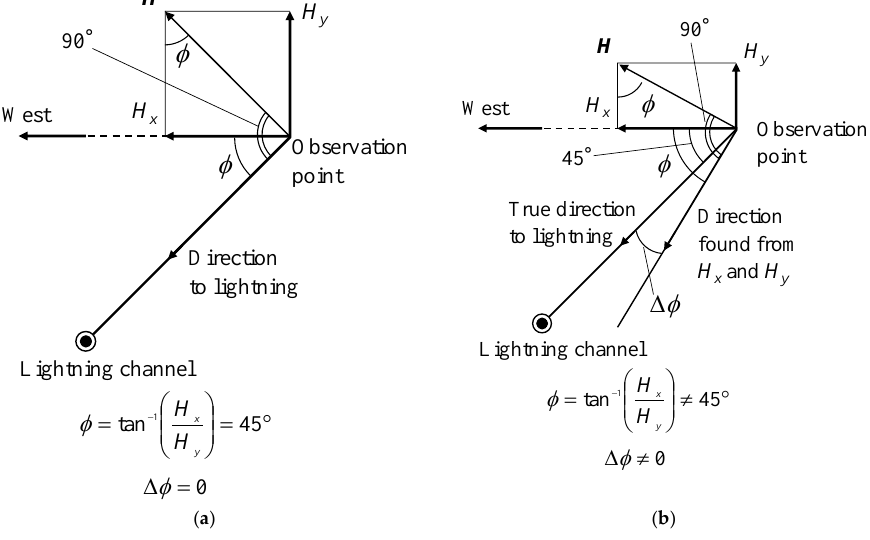
Figure 3. Illustration of lightning direction finding from H x and H y for the case of the true lightning azimuth φ = 45 0 : ( a ) Ideal case of no azimuth error (direction found from H x and H y is the same as the true direction to lightning); ( b ) the case of the presence of 60-m tall conducting structure at (7080, 7040) (see Table 1), which causes an azimuth error = 16.